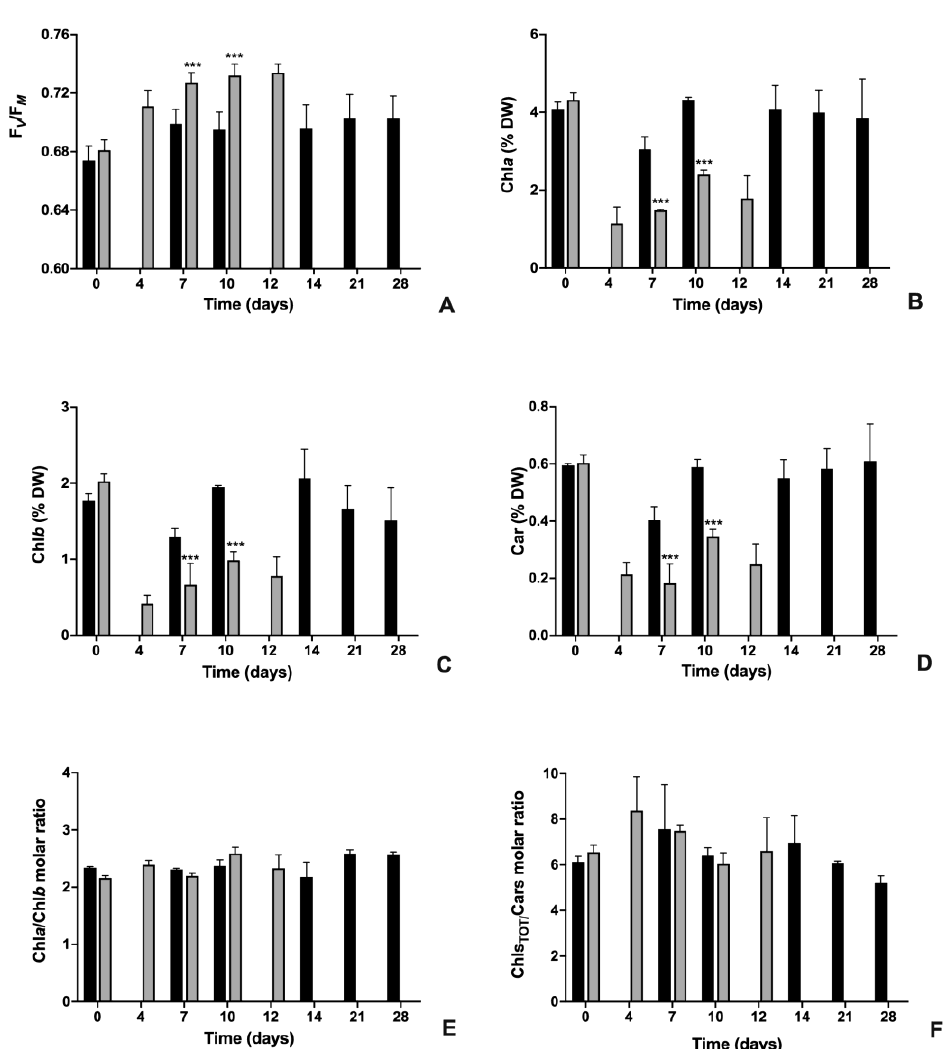
Figure 2. Time-course variations of the photosynthetic parameters of autotrophic (A) and mixotrophic (M) cultures of N. oleoabundans during a cultivation period of 28 d and 12 d for culture A and culture M, respectively. ( A ) Maximum quantum yield of PSII (F V /F M ratio). ( B ) Chlorophyll a content (Chl a , %DW). ( C ) Chlorophyll b content (Chl b , %DW). ( D ) Carotenoids content (Car, %DW). ( E ) Chlorophyll a over chlorophyll b molar ratio (Chl a /Chl b ). ( F ) Total chlorophylls over carotenoids molar ratio (Chls TOT /Cars). In ( E , F ), molar concentration of pigments (nmol PIG × 10 −6 cells) was used for calculations. Black histograms, culture A; grey histograms, culture M. Data refer to means ± standard deviations ( n = 3). When present, at each cultivation time, asterisks identify significant differences between cultures A and M as follows: ***, p < 0.001.